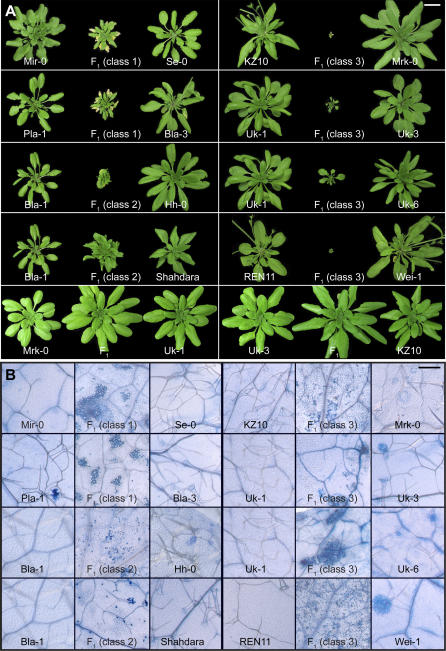
Range of Necrosis Phenotypes in A. thaliana Hybrids(A) Examples of necrotic hybrids representing three phenotypic classes defined in the text; 6-wk-old vegetative rosettes are shown. Two compatible hybrids, aged 5 wk, are shown in the bottom row for comparison. Scale bar (top right) represents 3 cm.(B) Trypan Blue staining for dead cells in leaves of hybrids and parents. Scale bar (top right) represents 250 μm.